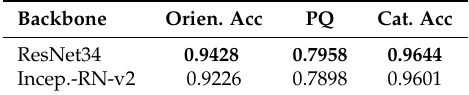
Table 4. Results of orientation recognition: The network can correctly recognize orientation in 94% of the correctly found animals (true positive).